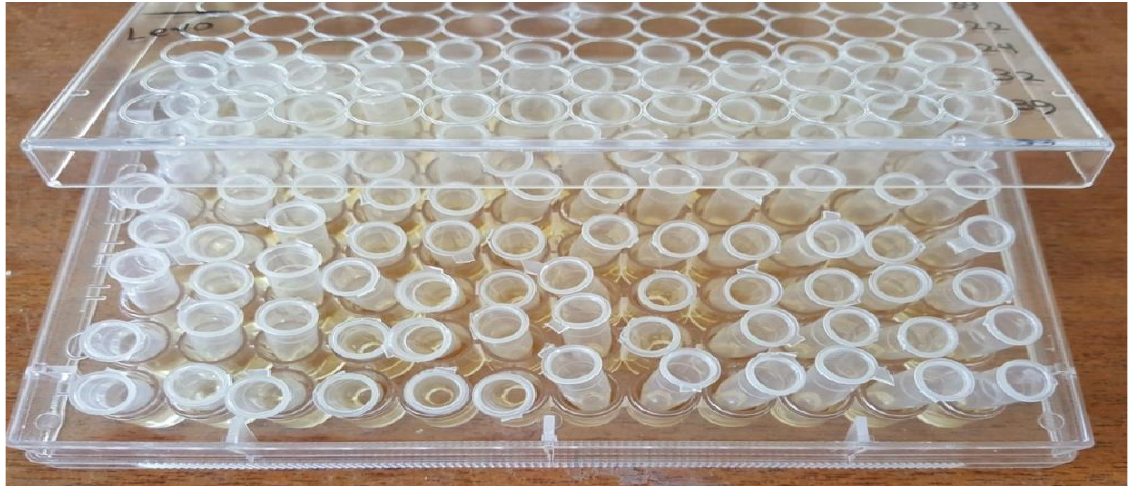
Figure 1. Bacterial suspension with autoclaved pegs to act as surface for biofilm